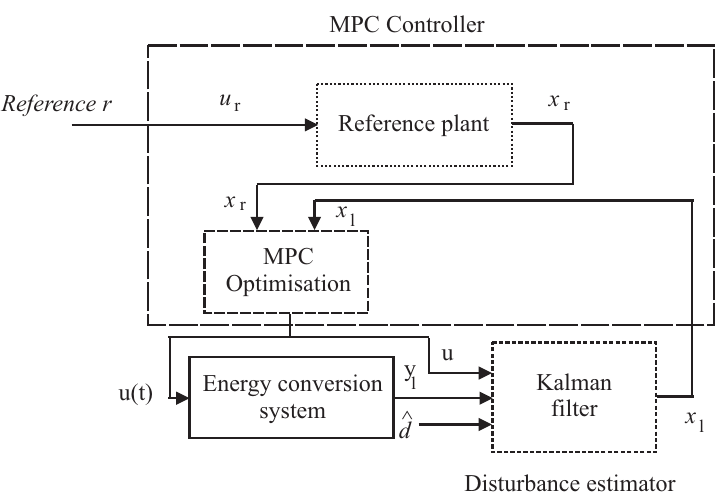
Figure 8. Block diagram of the disturbance compensated MPC